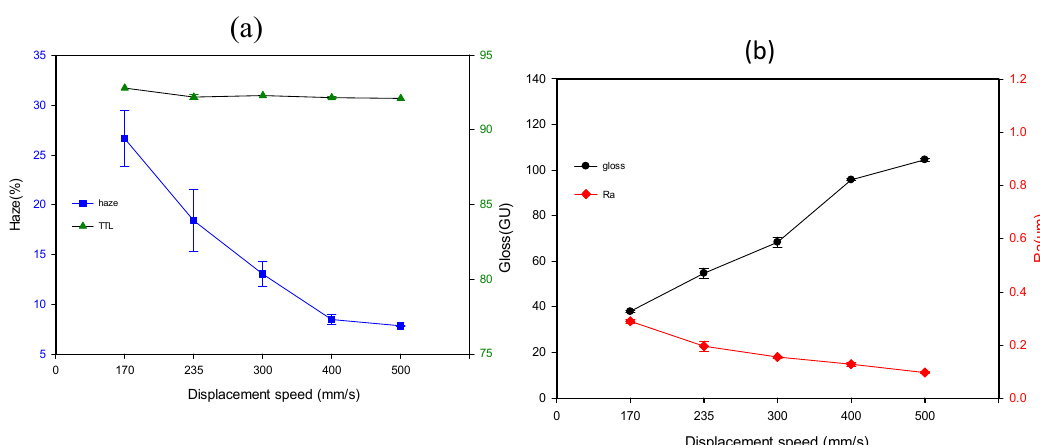
Figure 7. The influences of spray displacement speed on ( a ) haze and TTL, and ( b ) gloss and Ra with the sol-gel deliver and air transport pressures of 120 kPa and 300 kPa, respectively.